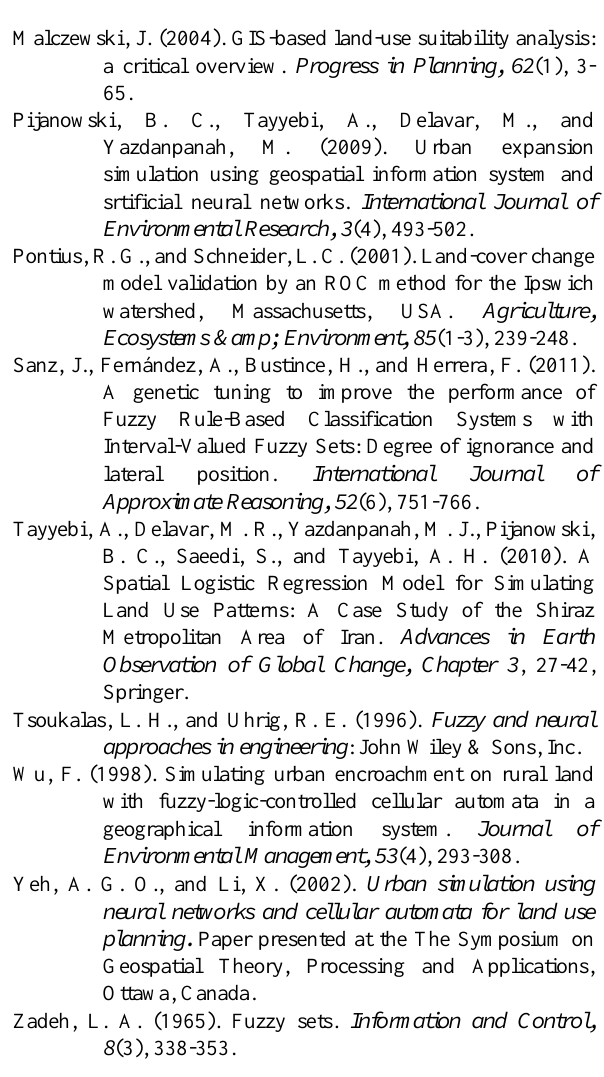
Figure 8. The real and simulated land use map of Tehran Metropolitan Area from 1988 to